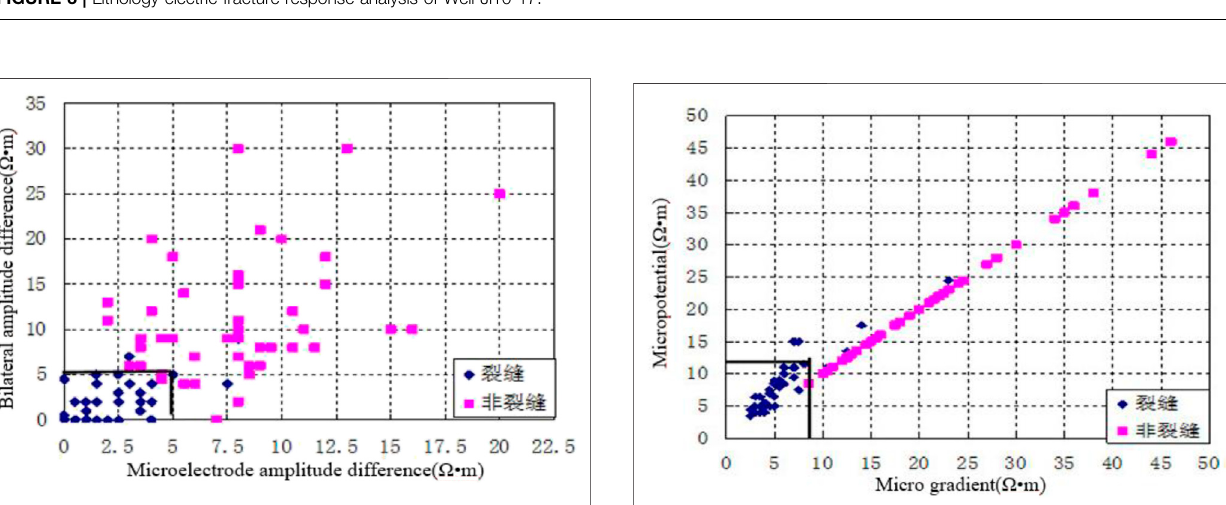
FIGURE 3 | Lithology electric fracture response analysis of Well Ji10-17.